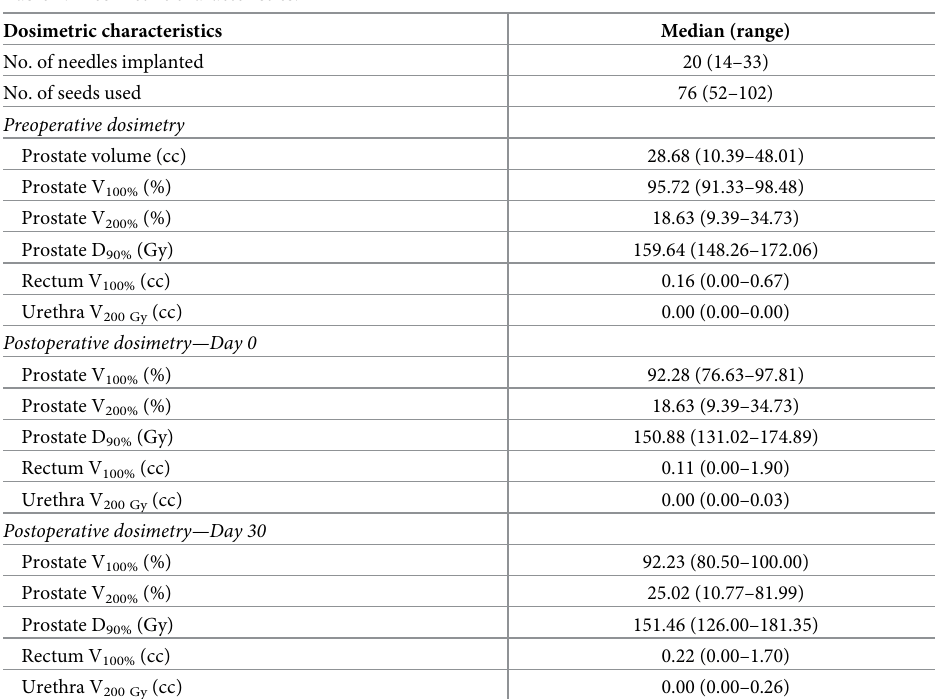
Table 2. Dosimetric